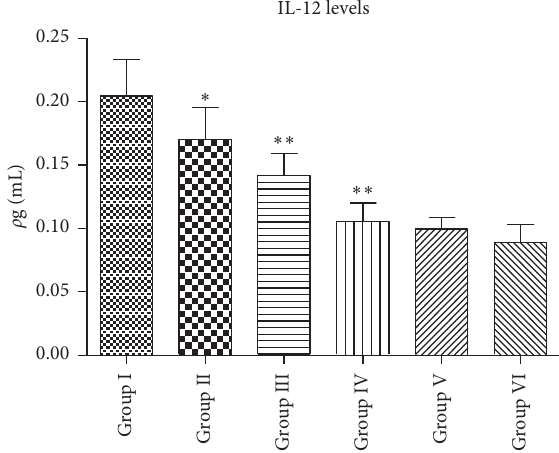
Figure 3: The plasma IL-12 levels (Group I � negative control, Group II � EA200, Group III � EA300, Group IV � EA400, Group V � positive control, and Group VI � normal control; data are presented as mean ± SEM), ∗ p > 0 . 05 vs. Group I; ∗∗ p < 0 . 05 vs. Group I.